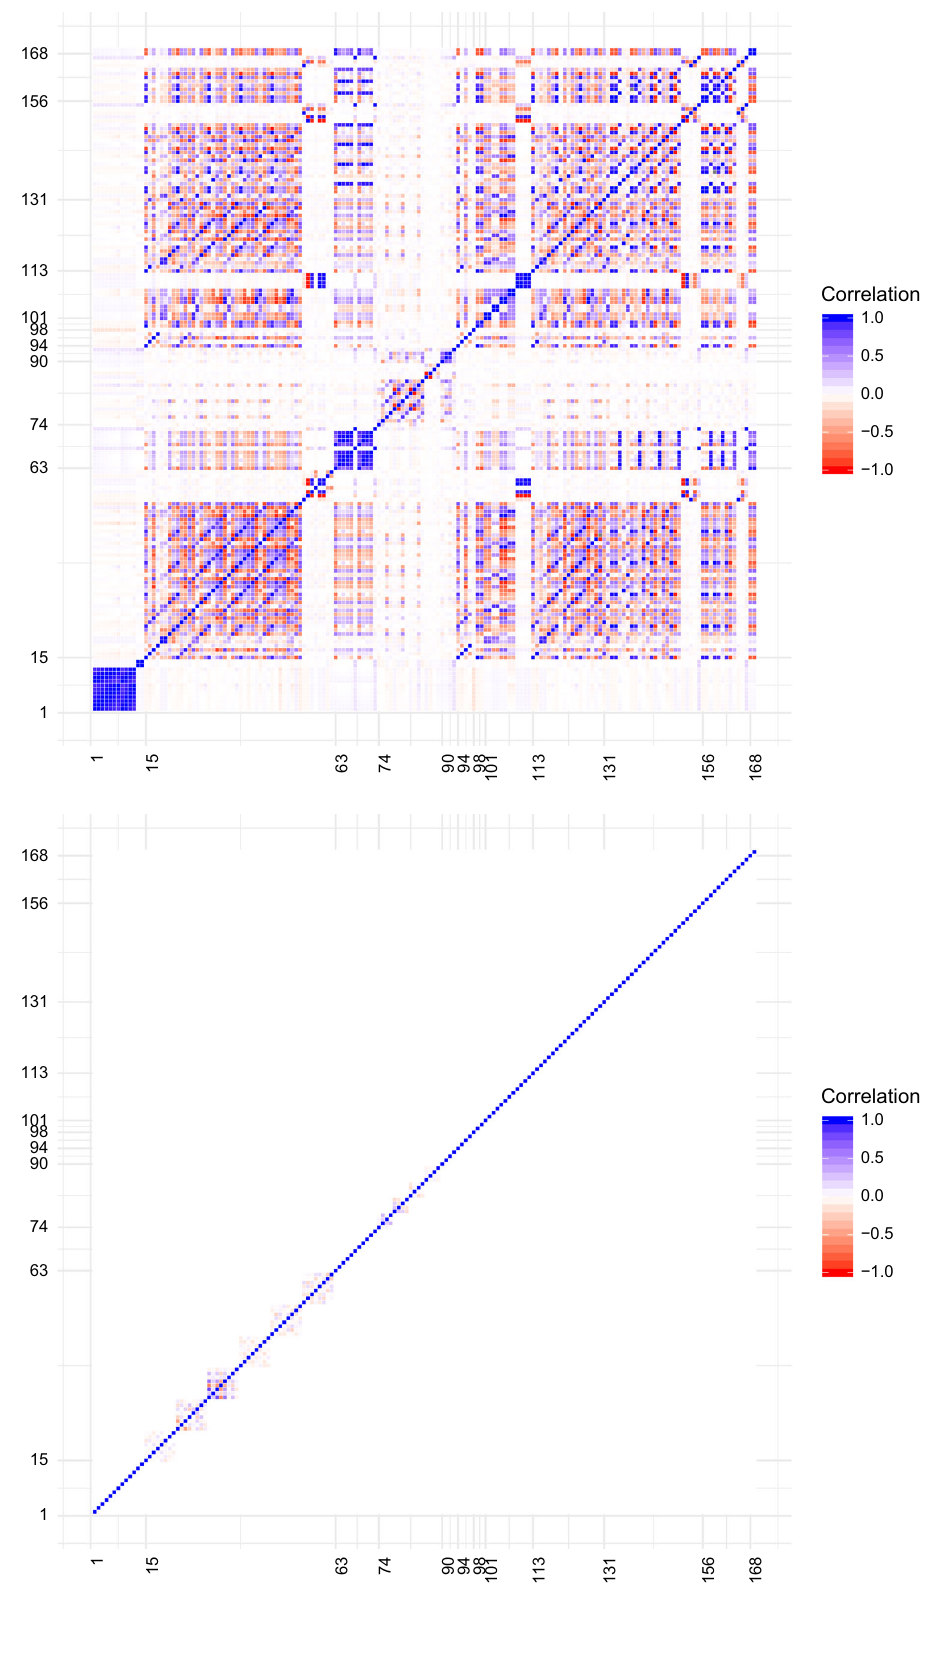
Fig. 14 Correlation maps derived from the covariance matrix of theory errors (top panel) and experimental errors (bottom